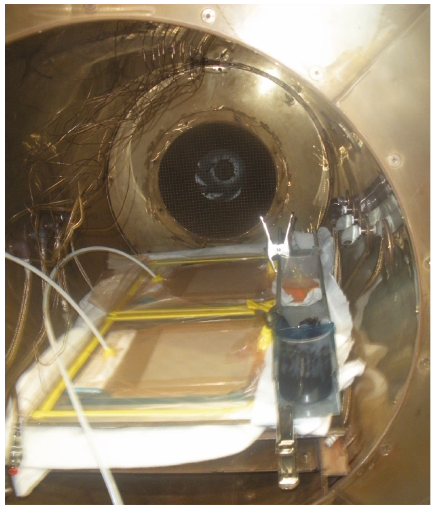
Figure 3: Infusion